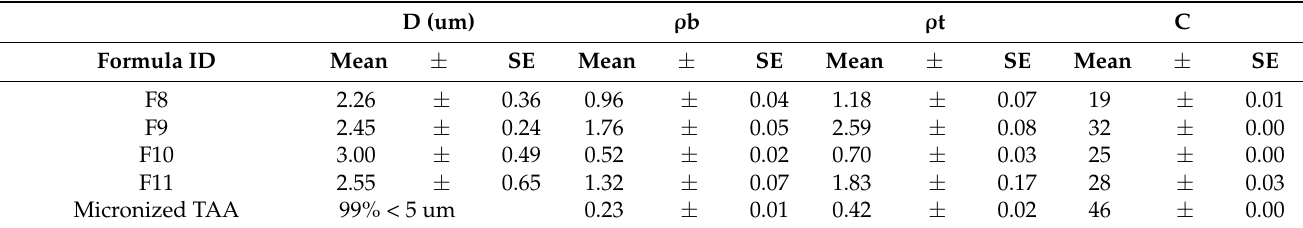
Table 4. Physical examination results of TAA spray-dried products with ABC blowing agent in comparison with micronized